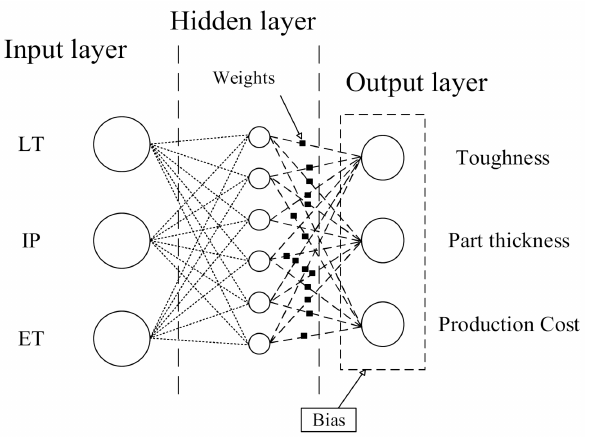
Figure 1. The architecture of an artificial neural network